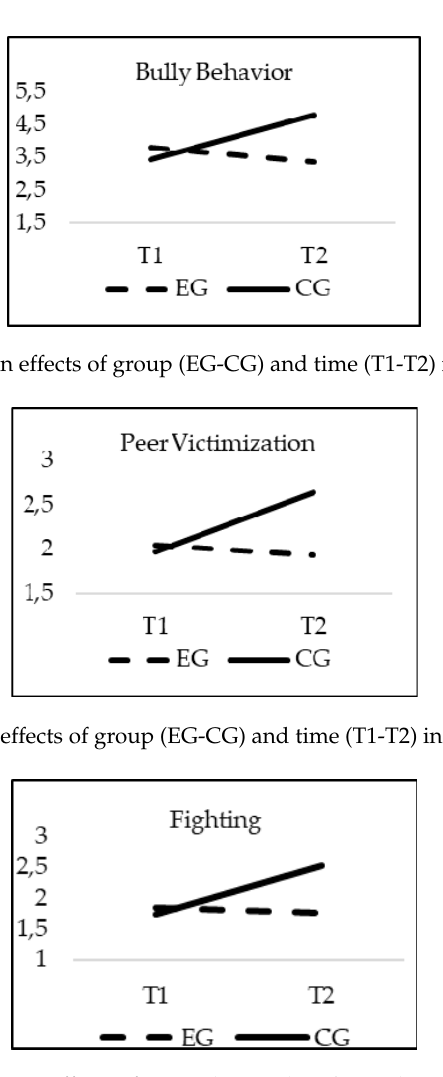
Figure 3. Interaction effects of group (EG-CG) and time (T1-T2) in Fighting.